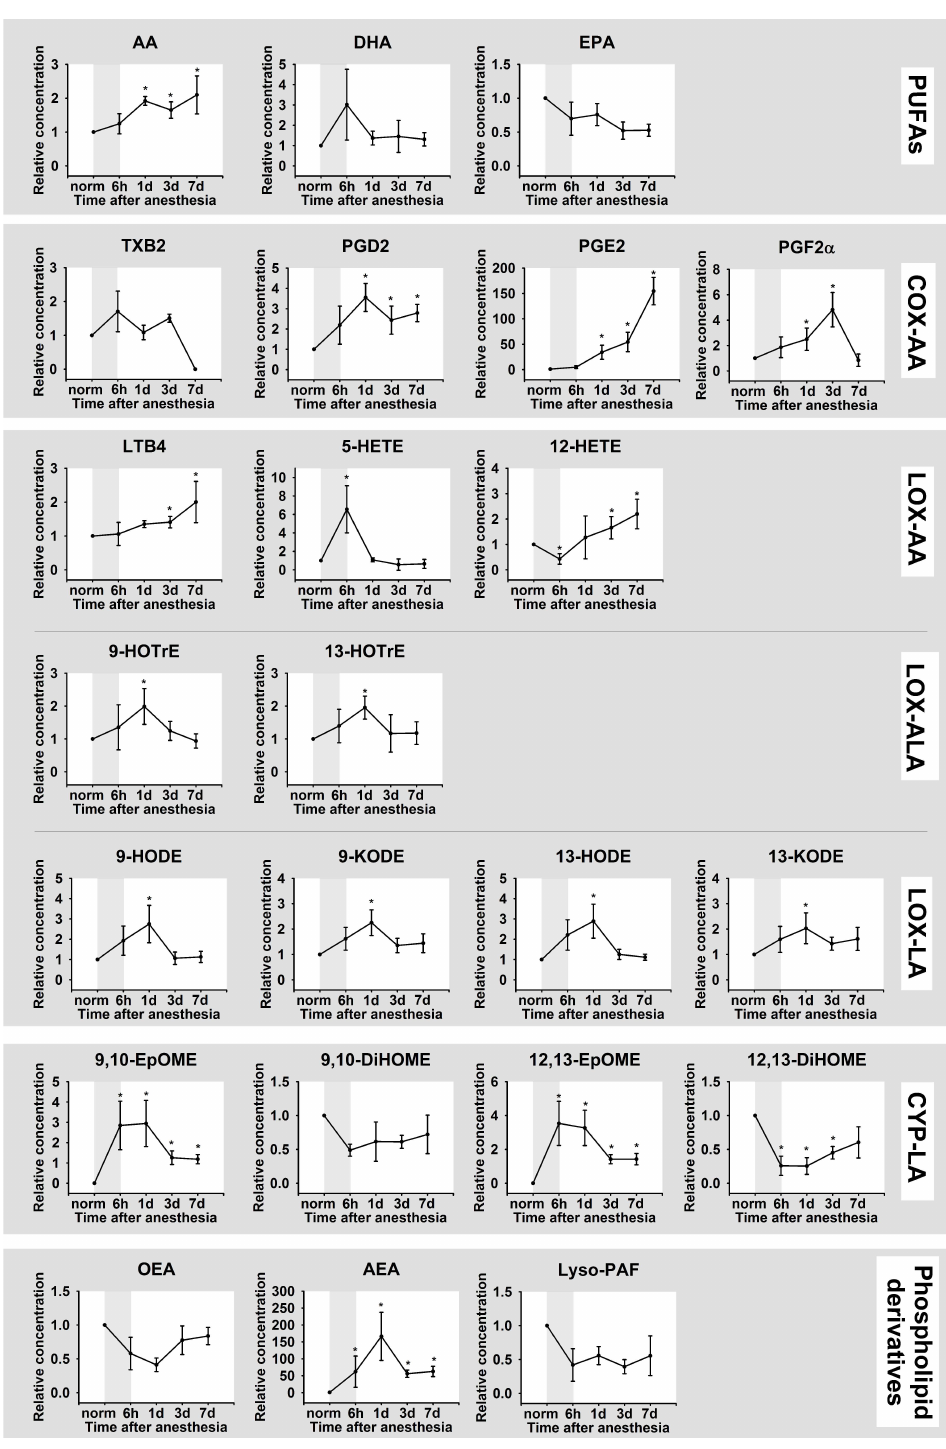
Figure 4. Dynamic changes in TF content of lipid mediators in DES. The animals were exposed to general anesthesia for 6 h (shown as gray box). TF samples were collected before (norm) and immediately after (6 h) the general anesthesia as well as on 1, 3, and 7 day post-exposure. The concentrations of the lipid mediators (phospholipid derivatives, PUFAs and oxylipins) in TF were measured using quantitative UPLC-MS / MS analysis. * p < 0.05 as compared to the parameters of TF of the intact (control) animals. The identified oxylipins are divided into subgroups according to their precursors (AA, ALA, LA, phospholipids) and major biosynthetic pathways, involving COX, LOX, or